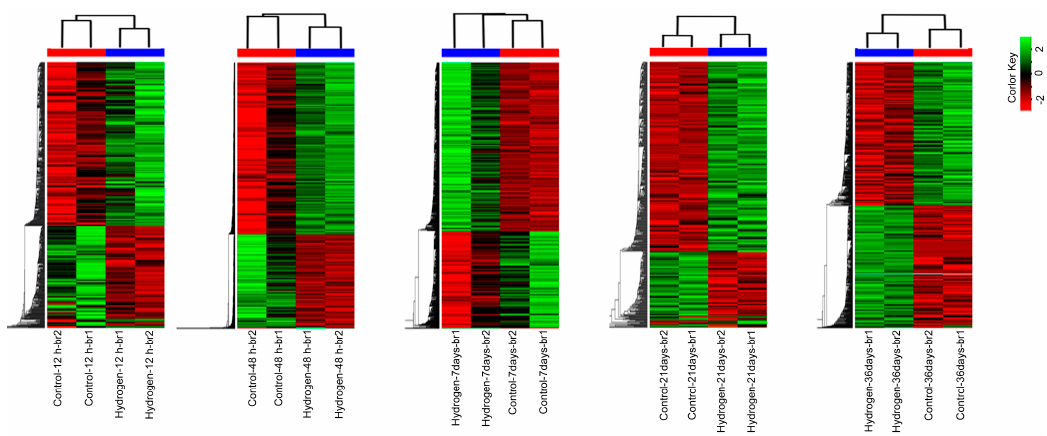
Figure 2. Hierarchical clustering maps of differentially expressed genes (DEGs) after 12 h, 48 h, 7 days, 21 days, and 36 days of hydrogen treatment. The color scale shows log 2 fold changes (FC). FC = normalized TPM (transcripts per million) values in H 2 -treated PEMs/normalized TPM (transcripts per million) values in control PEMs. br1/br2: two biological replicates, respectively. Red color line indicates br1/br2 clustering of control PEMs and blue color line indicates br1/br2 clustering of H 2 -treated PEMs at each time point.